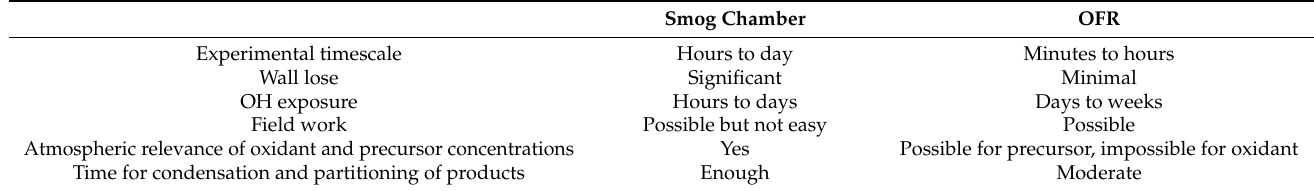
Table 1. Comparison of features between smog chamber and OFR